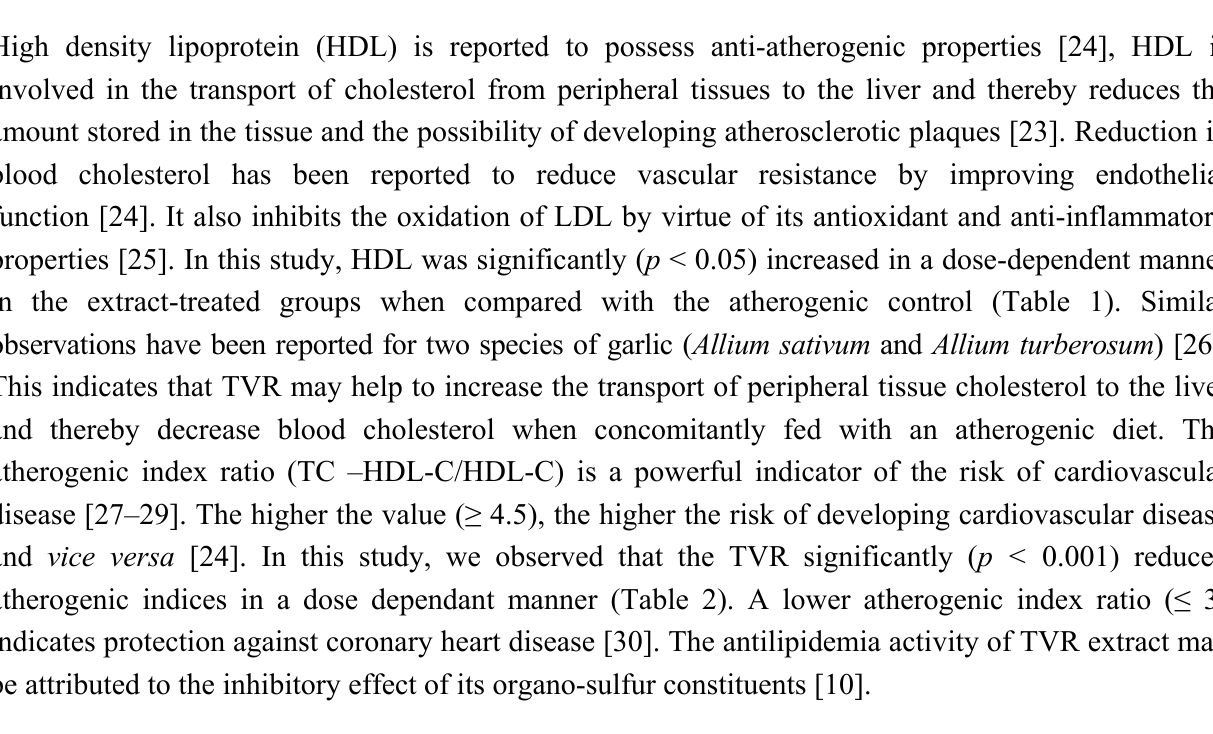
Table 2. Effect of methanolic extract of Tulbaghia violacea rhizomes (TVR) on serum lipid profile in diet-induced atherogenic